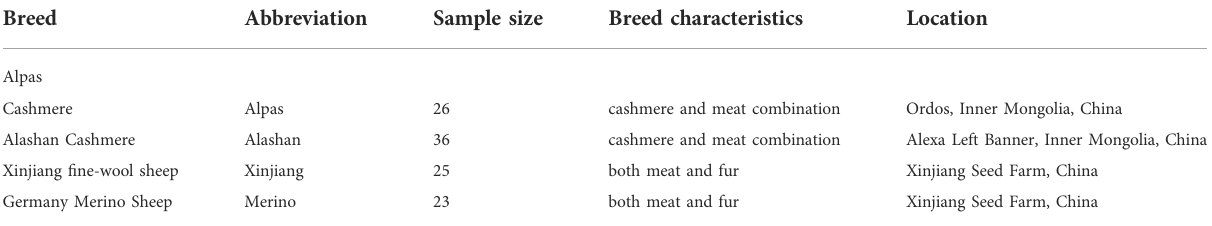
TABLE 1 Fiber sample